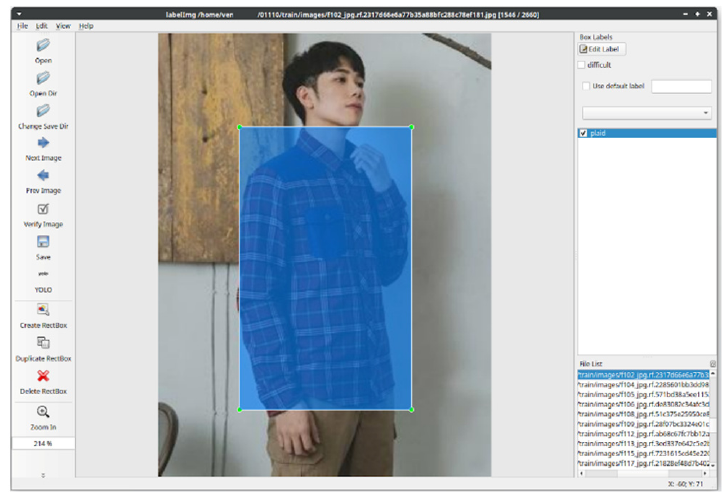
Figure 7. Outcome of image labelling.